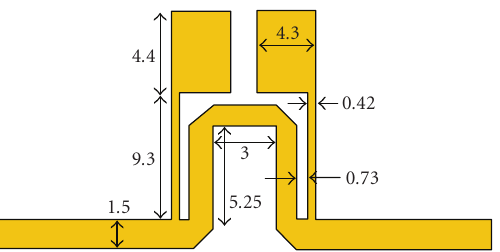
Figure 10: The shaped stepped impedance bandstop filter with dimensions in